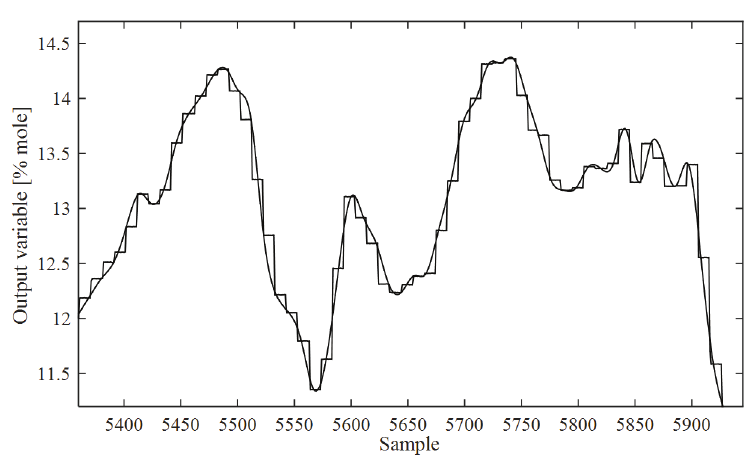
Fig. 7 – Cubic spline interpolated output data and the real analyser